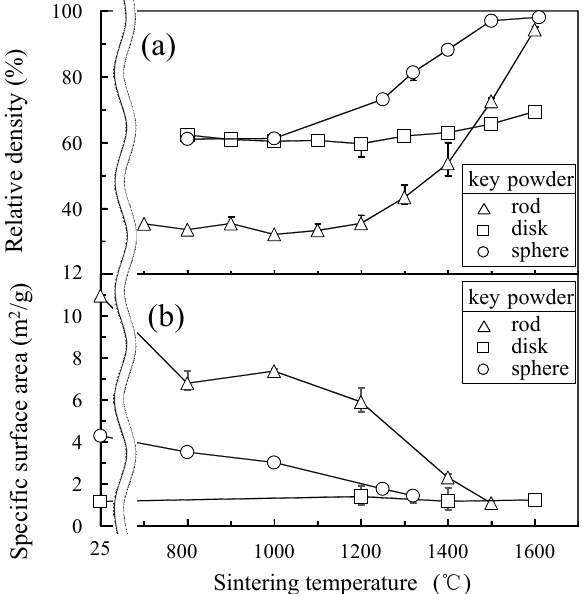
Figure 2. Relation between sintering temperature and ( a ) relative density or ( b ) specific surface area of sintered alumina compacts.